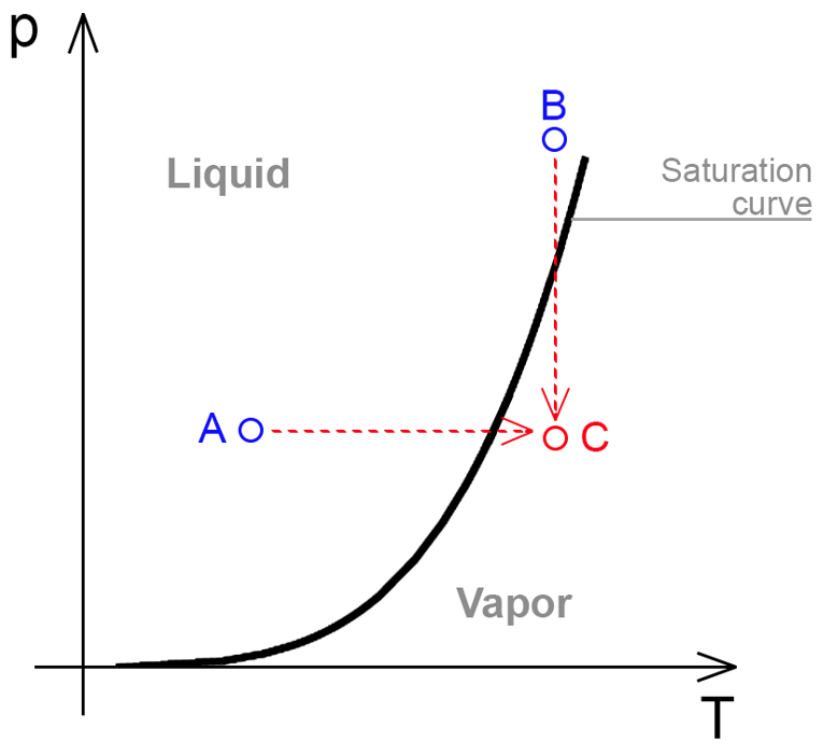
Figure 2. Phase diagrams for flash Figure 2 . Phase diagrams for flash evaporation.